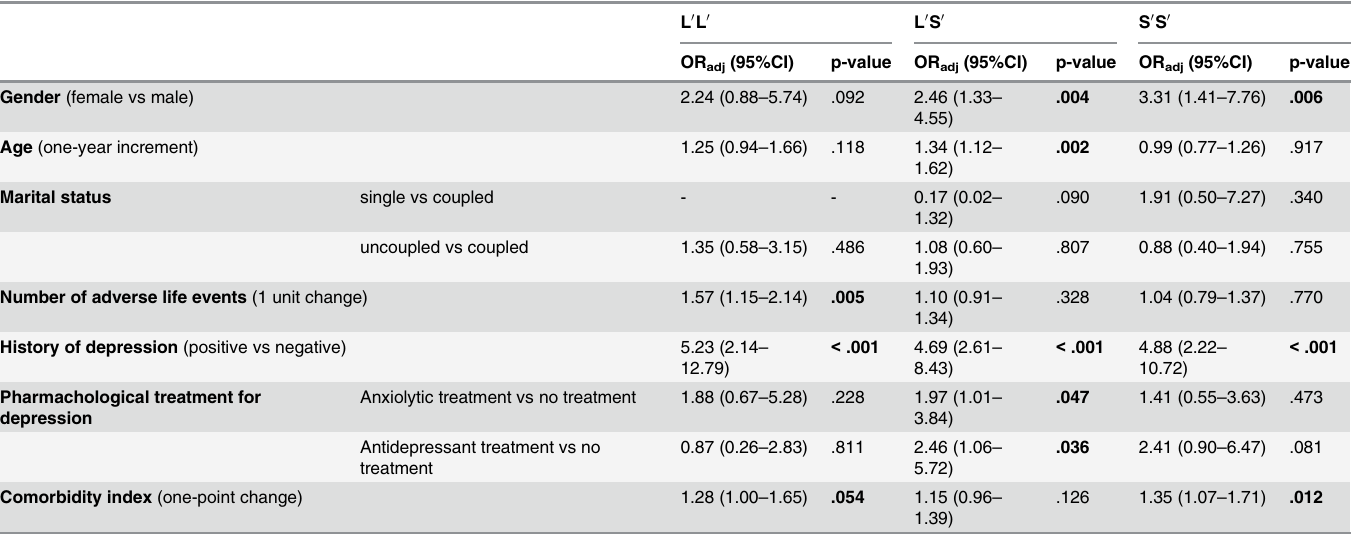
Table 3. Within combined genotypes, mutually adjusted associations of depressive symptoms * (relevant vs not relevant) with adverse life events, pharmacological treatment for depression, history of depression, marital status, comorbidity index, gender and age distribution. Adjusted odds ratios (OR adj ) with confidence intervals (95%CI) and p-values are reported^